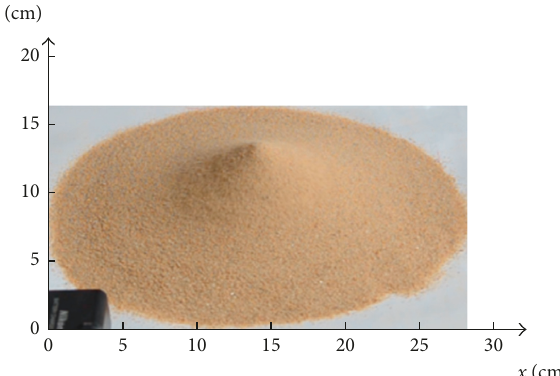
Figure 4: The final configuration of sand